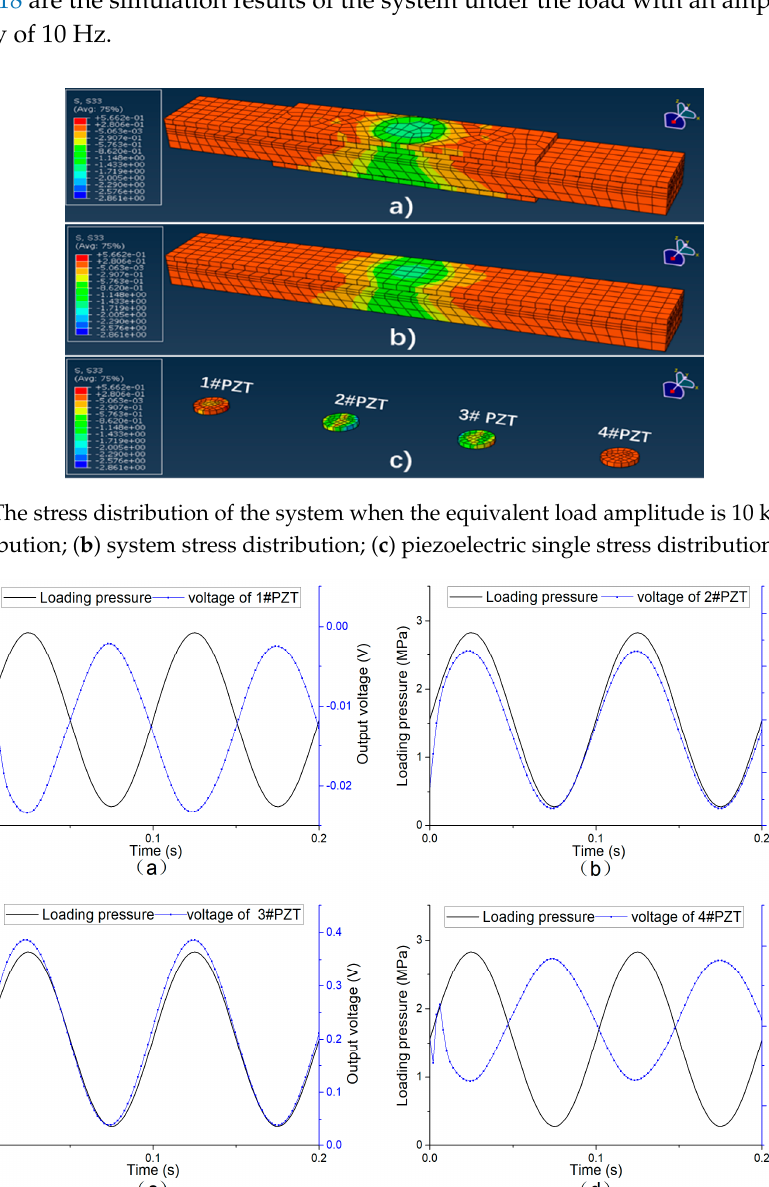
Figure 16. Output voltage peak-to-valley value vs. load frequency when loading amplitude is 10 kN. ( a ) Output of each piezoelectric unit; ( b ) piezoelectric sensing system total output.